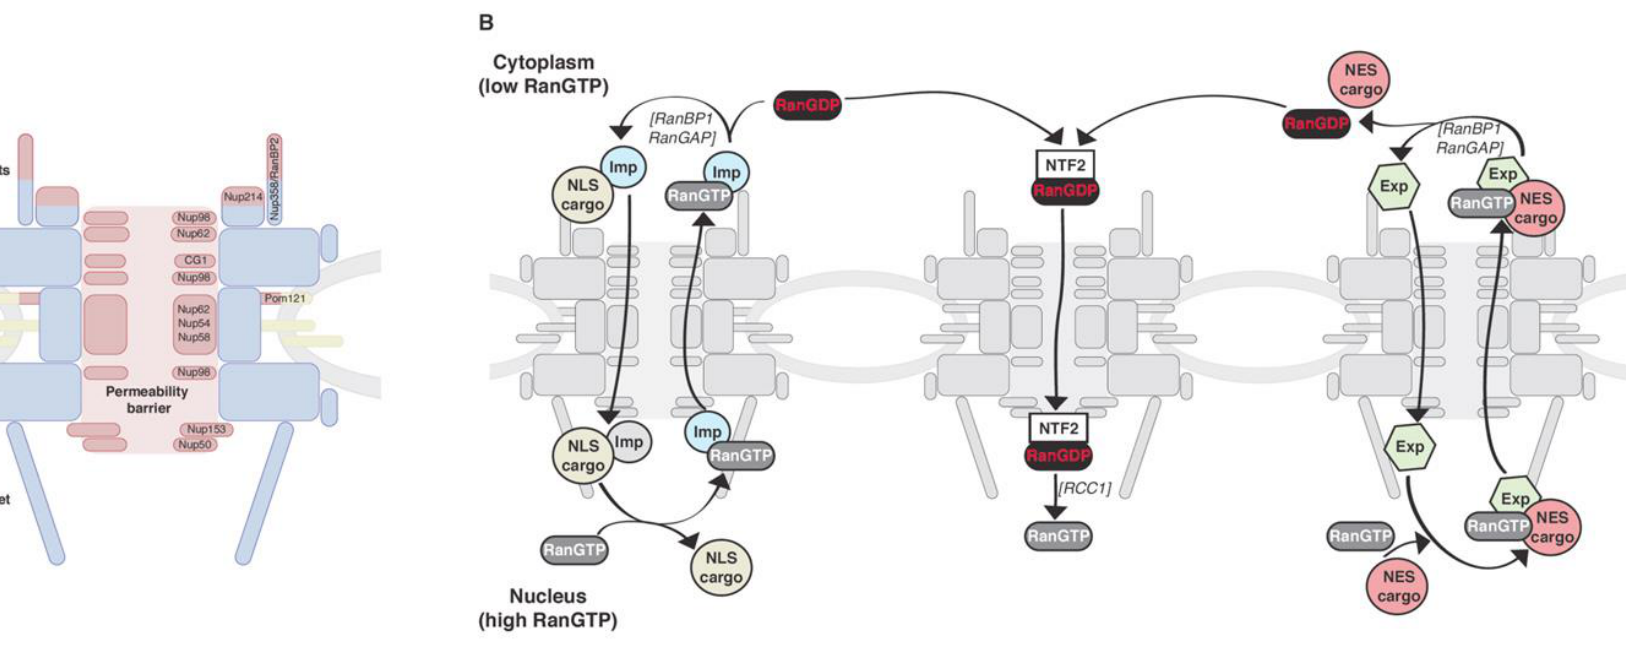
Figure 1. Schematic represenation of metazoan NPC composition and nucleocytoplasmic